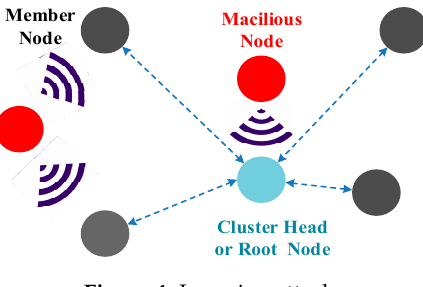
Figure 4. Jamming Figure 4. Jamming attack.